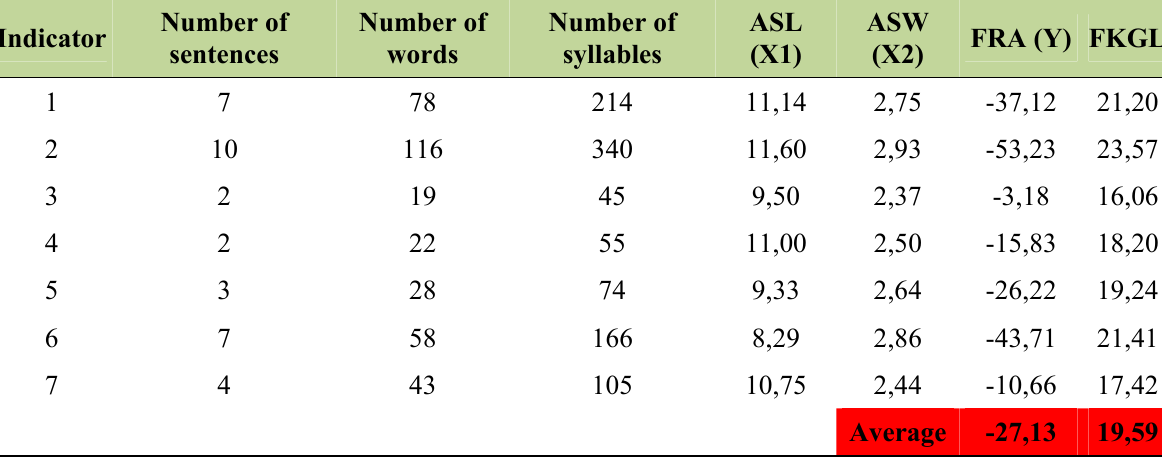
Table 5. Result of SPBE Instrument